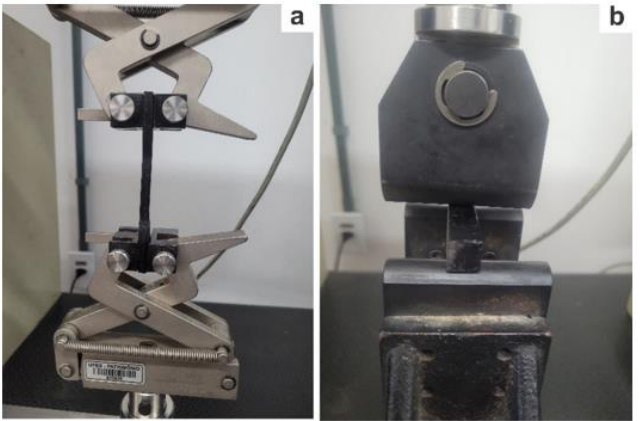
Figure A1. Demonstration of the charcoal fines produced.